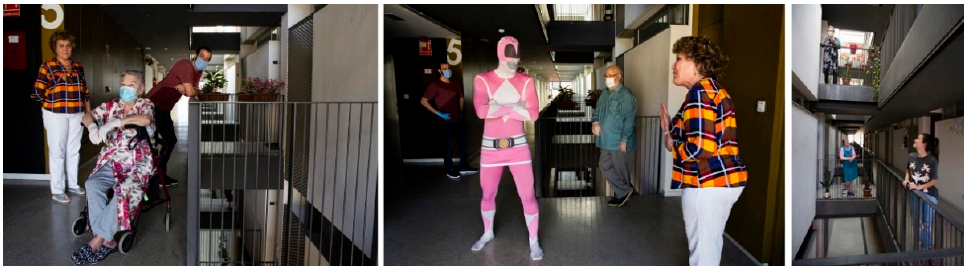
Figure 15. Plaza de América building’s interior street during the COVID-19 pandemic, 2020. Cour- tesy of Rafa Arjones, Diario Información . of Rafa Arjones, Diario Informaci ó n